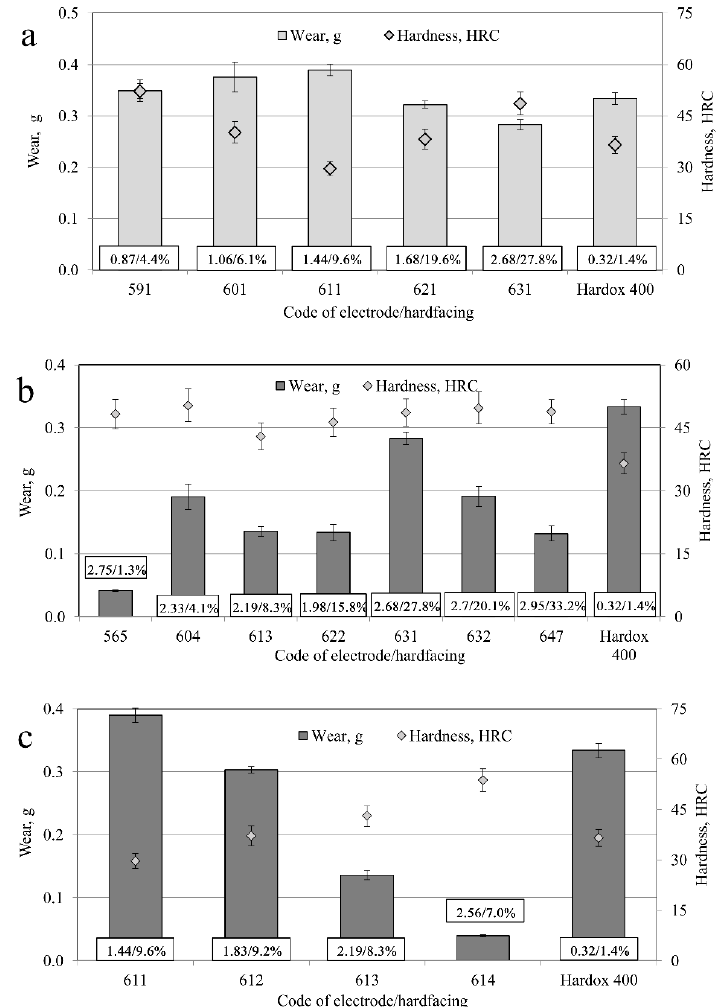
Figure 6. Effect of chromium and carbon ( a ), chromium ( b ), and carbon ( c ) on the wear rate and